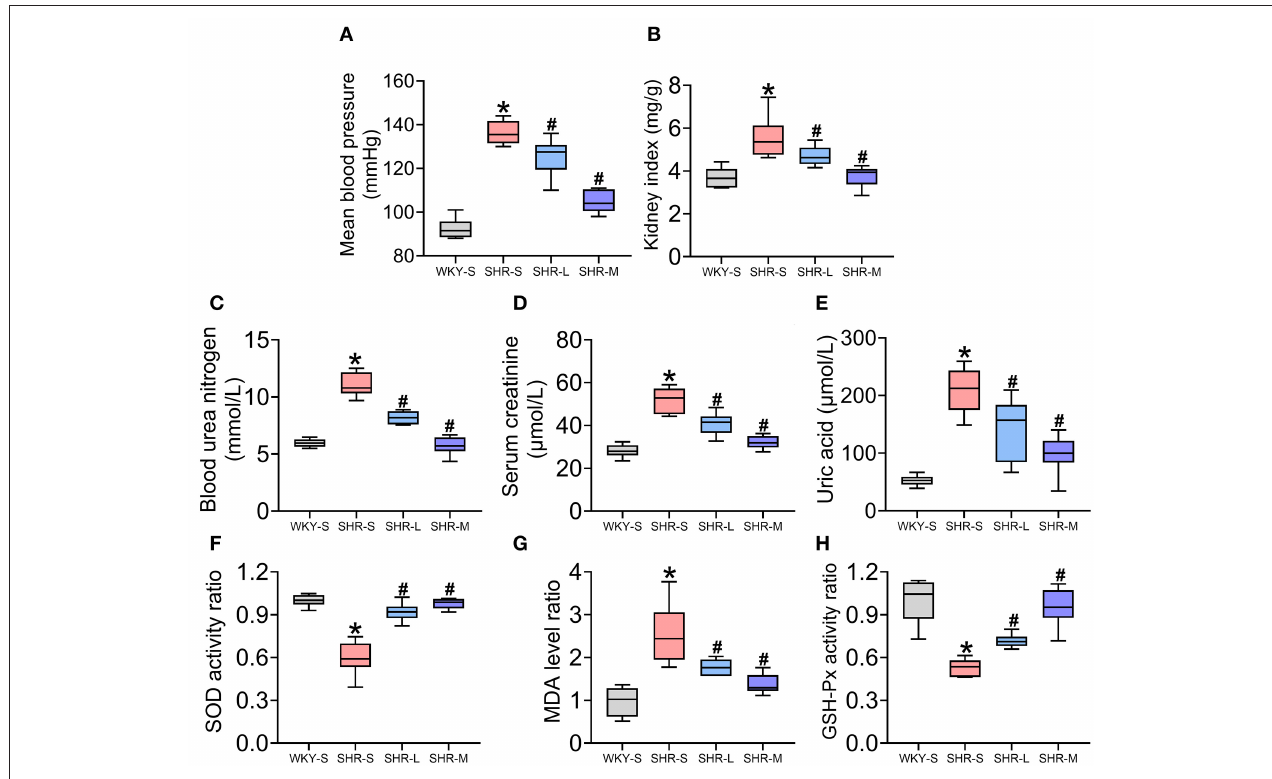
FIGURE 1 | Effect of aerobic exercise training on mean blood pressure (MBP), renal function, and oxidative stress in spontaneously hypertensive rats (SHR). (A) MBP (B) kidney index (C) blood urea nitrogen (D) creatinine (E) uric acid (F) superoxide dismutase activity (G) malondialdehyde levels, and (H) glutathione peroxidase activity in serum were measured in all groups. Data are presented as Box-whisker Plot. * P < 0.05 (WKY-S vs. SHR-S), # P < 0.05 (SHR-L, SHR-M vs. SHR-S).